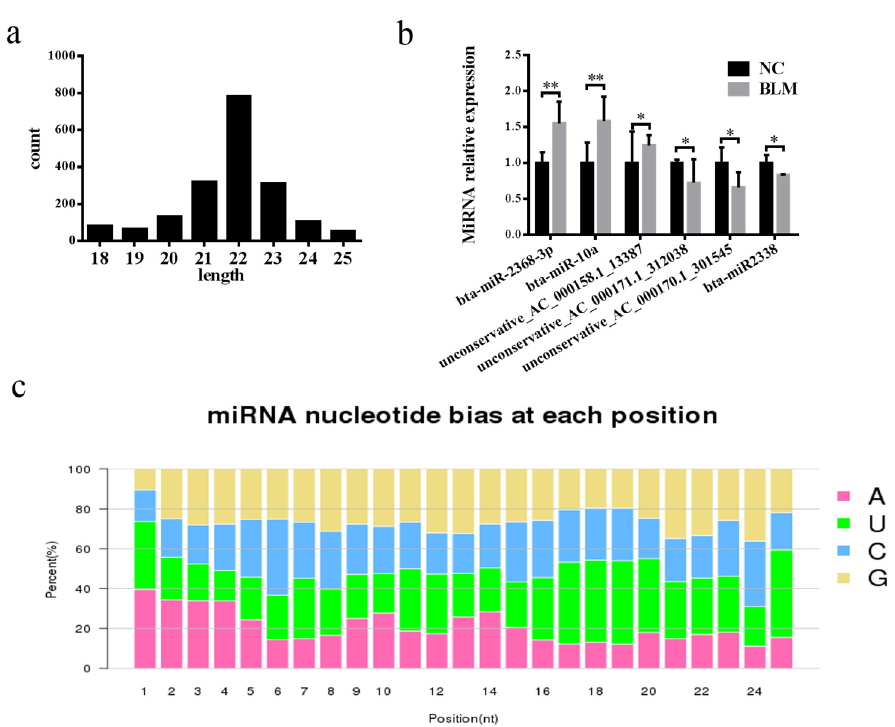
Figure 6. Identification of differentially expressed miRNAs. ( a ) miRNA length analysis. ( b ) Expres- sion of up- and downregulated miRNAs in the NC and BLM groups, as determined by RT–PCR. ( c ) miRNA nucleotide bias at each position. Significant differences are represented with *( p < 0.05) and **( p < 0.01).